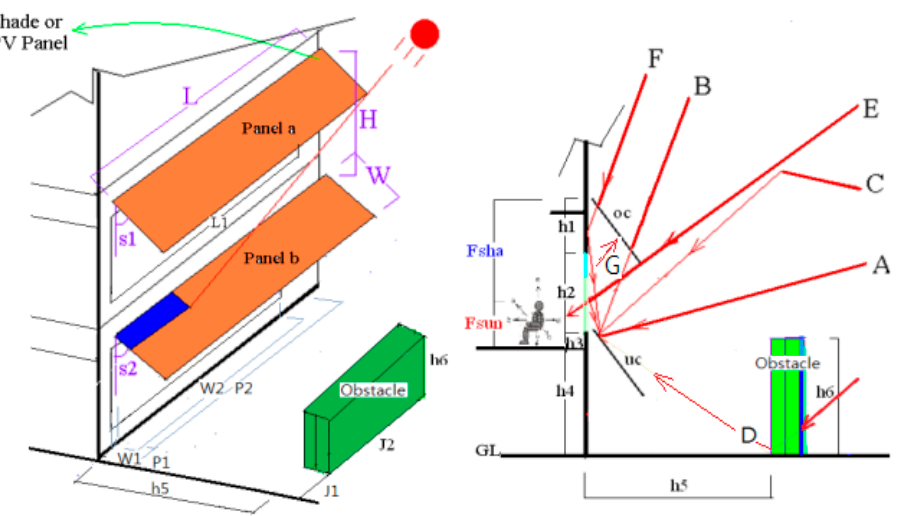
Figure 6. The principle of the eave and the energy harvesting for the bi-facial PV module.